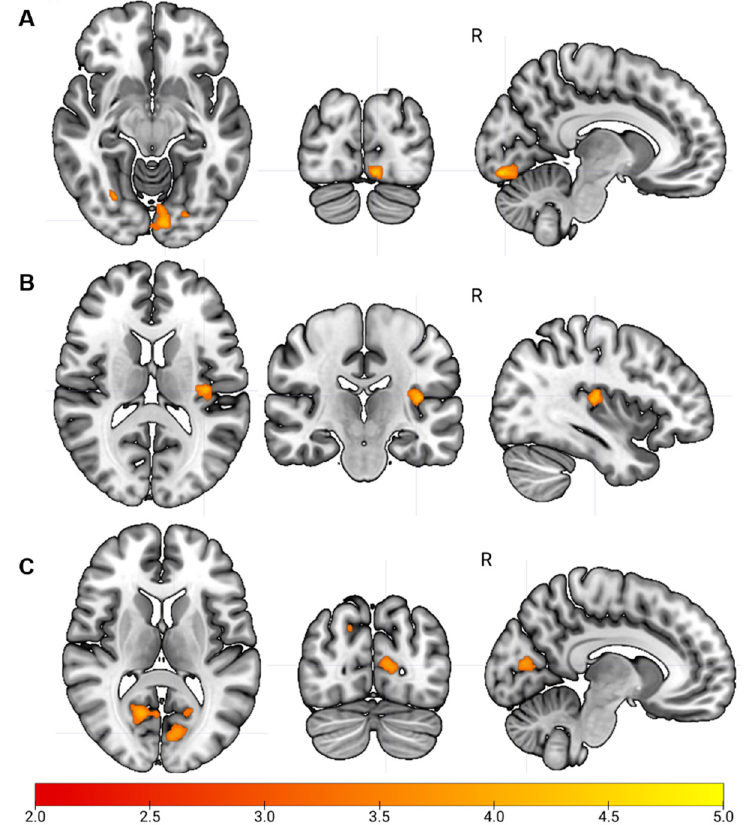
Figure 2. Clusters of significantly lower functional connectivity in the youth with CP relative to the controls. ( A ) Lower functional connectivity between the left precentral gyrus (seed) and the right cuneus; ( B ) lower functional connectivity between the left lingual gyrus (seed) and the right Heschl gyrus; ( C ) lower functional connectivity between the left Heschl gyrus (seed) and the right and left lingual gyri. Detail of the clusters can be found in Table 2. Significant threshold was set at a whole-brain level of p < 0.001 uncorrected, clusters >20 voxels. The scale shows the z-score.